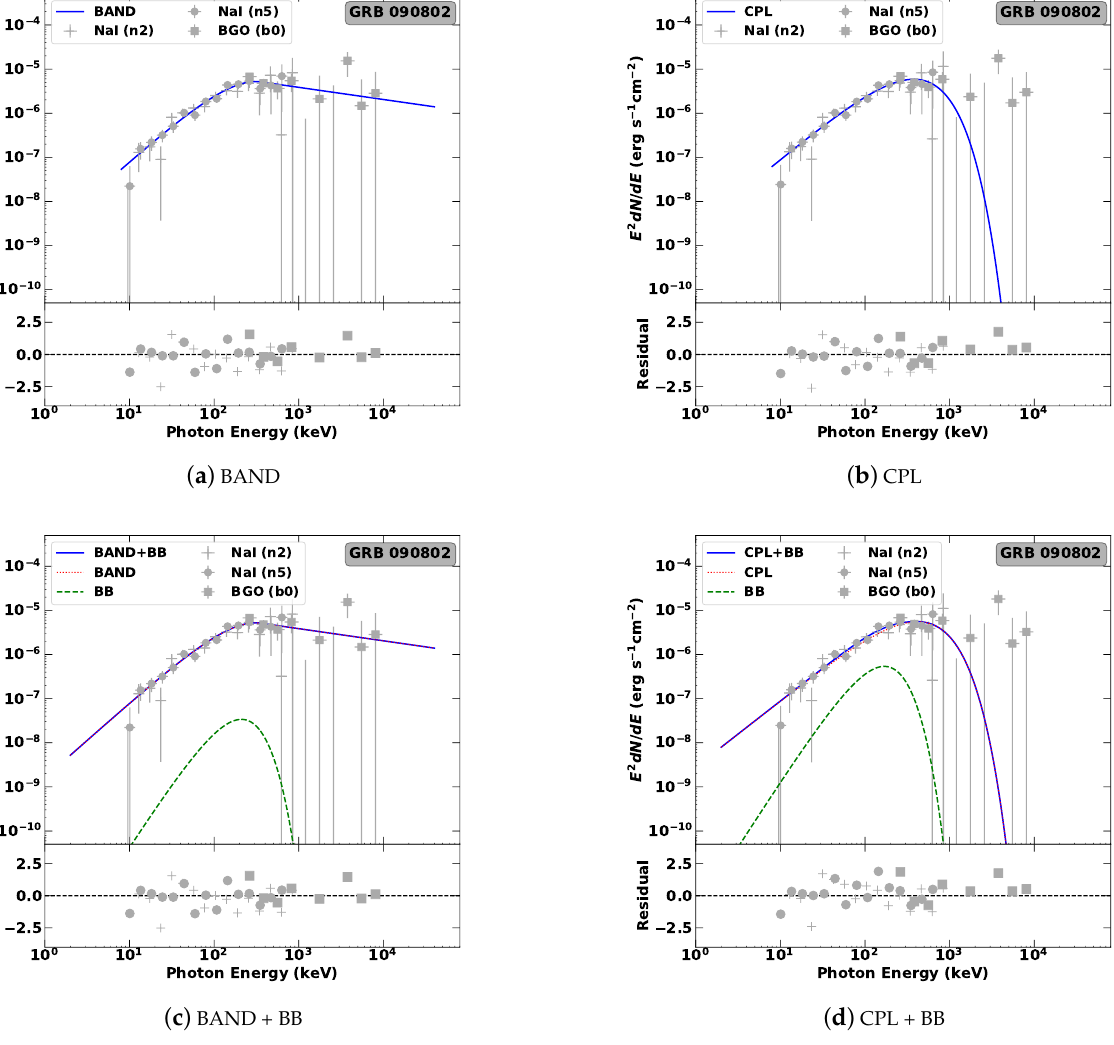
Figure 5. Spectral-fitting results for one GRB in class (ii) that with R < 0.1 in both of the BAND + BB model and the CPL + BB model, such as GRB